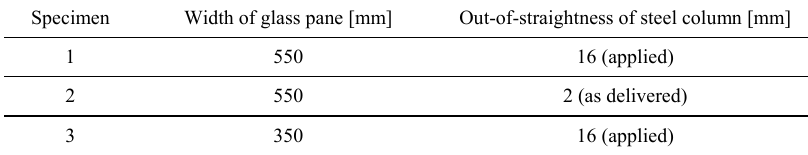
Figure 4: Schematic representation of the different test specimens. Table 1: Variations in the geometry of the different test